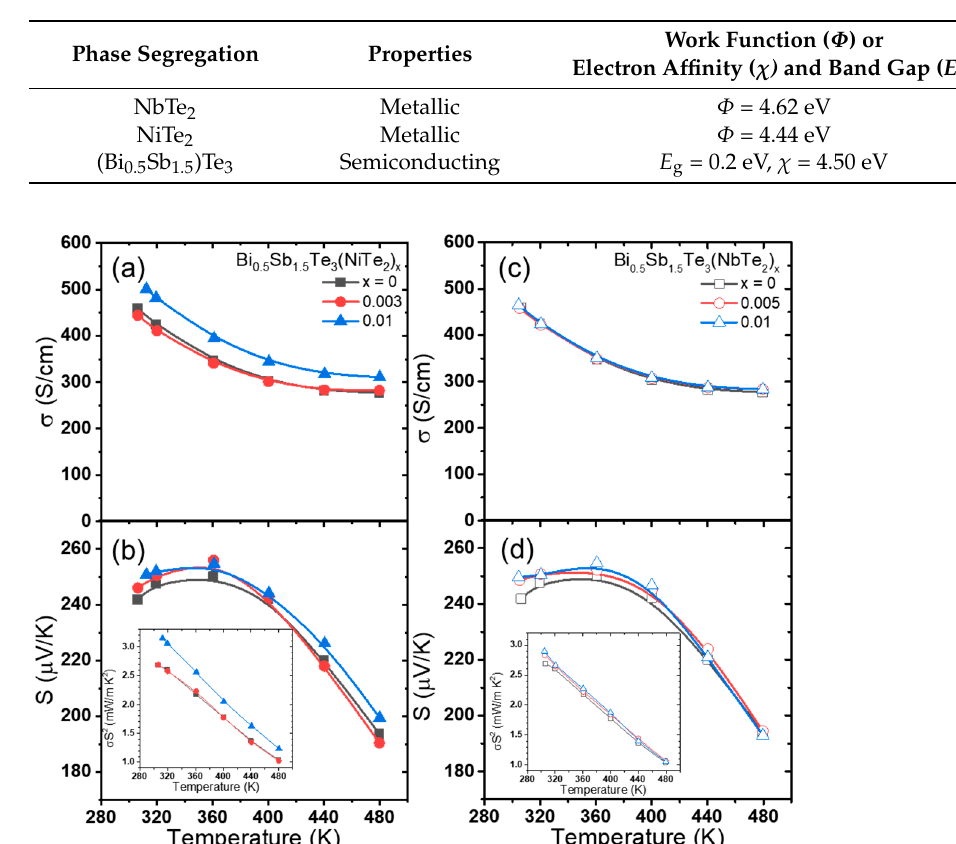
Figure 2. Schematic of energy band diagrams of the samples at the heterointerfaces between Bi 0.5 Sb 1.5 Te 3 and the secondary phase: ( a ) NiTe 2 and ( b ) NbTe 2 . Table 1. Work function ( Φ ) for NbTe 2 and NiTe 2 , and electron affinity ( χ ) and band gap ( E g ) for (Bi 0.5 Sb 1.5 )Te 3 .